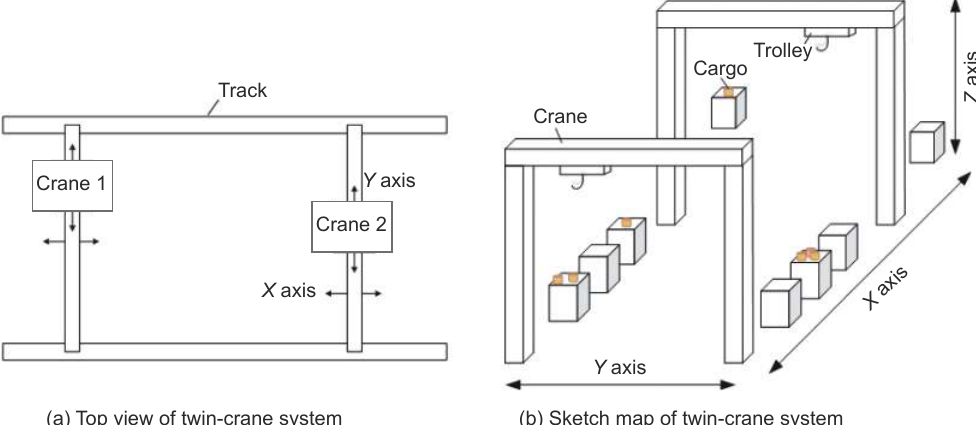
Fig. 1 Overview of a twin-crane